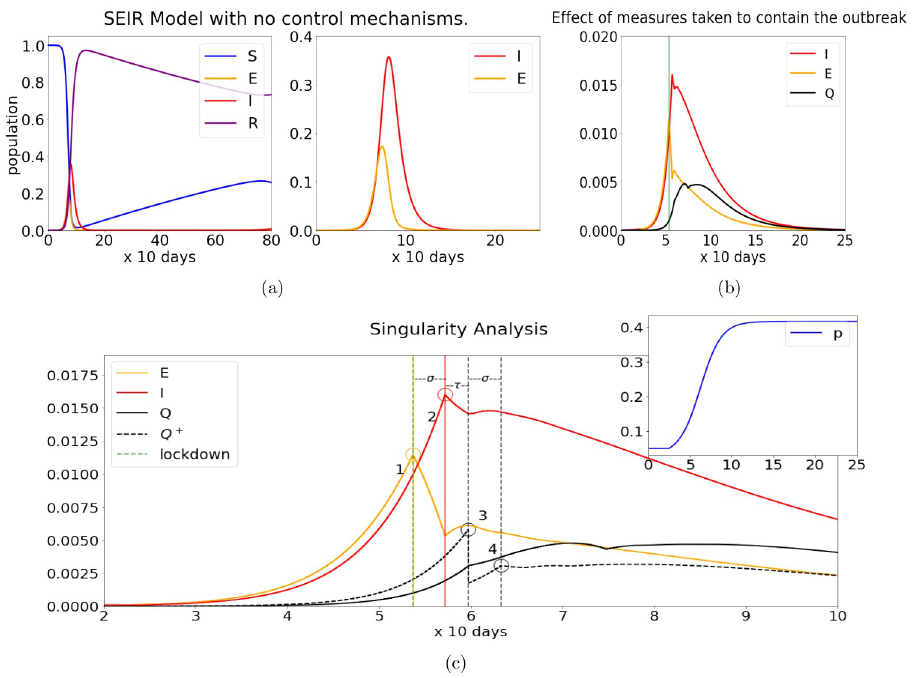
Fig 1. Basic model of early developments with and without control mechanisms. The left panel of (a) shows the development of an uncontrolled epidemic over the course of 800 days, simulated using the SEIR equations. The right panel of (a) takes a closer look at the curves for the [E]xposed and [I]nfected population. (b) shows the effect of a sustained lockdown and of isolating known infectious hosts [Q]; these efforts severely stunt the growth of the infection, lowering the peak of the infectious population from * 36% to * 1.6%. Plot (c) takes a detailed view of the singularities caused by the lockdown, which cascade through the system offset by the respective delay. The vertical green lines in (b) and (c) denote the time when alarms are raised ( t 1 , dashed) and when the lockdown begins ( t 2 , solid). Points of interest marked 1–5 in (c) are discussed in the text. The inset plot shows how testing ability ( p ) increases to its maximum over the course of 10